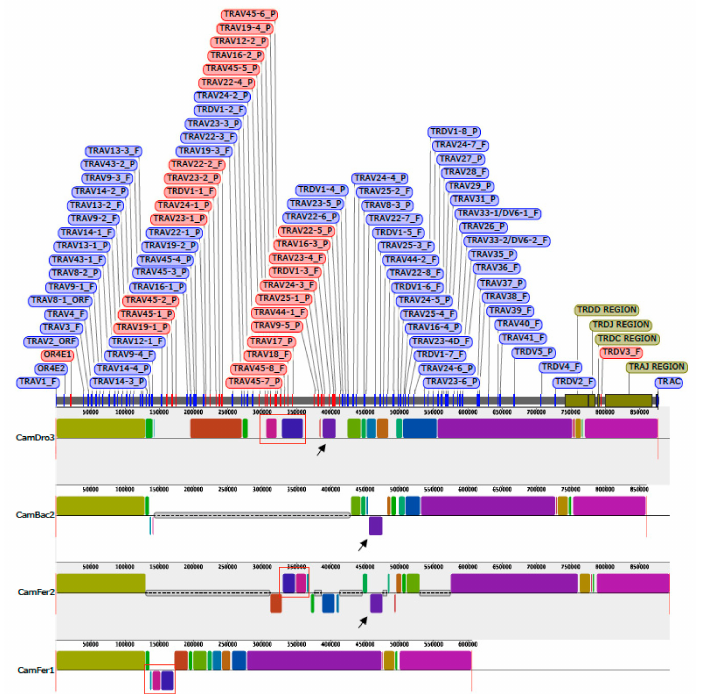
Figure 5. Schematic representation of the comparison of the dromedary (CamDro3) TRA/TRD genomic region with Bactrian (CamBac2) and wild Bactrian (CamFer2 and CamFer1) sequences. Colored blocks highlight syntenic regions between the different assemblies. Blocks below the line indicate sequences of inverted orientation with respect to the reference CamDro3. The grey thin boxes represent sequencing gaps. The position of all dromedary TRA and TRD genes is reported. The genes with an opposite orientation within the dromedary TRA/TRD locus are marked in red. The black arrows and the red boxes are described in the